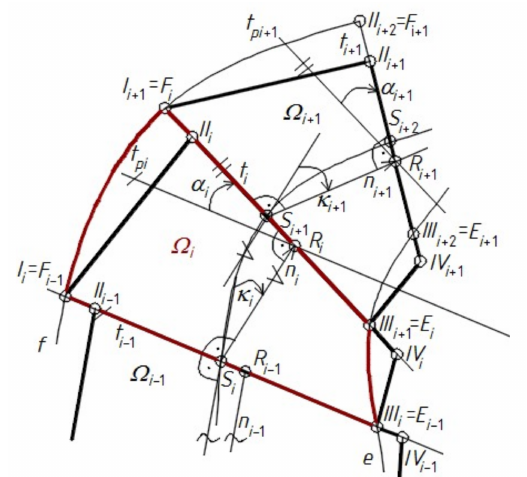
Figure 16. Models of two effectively twisted, bent, and sheared subsequent shell folds limited by pairs of two skew straight lines { t i , t i +1 }, which are determined on the basis of a discontinuous sum of many R i S i straight sections.